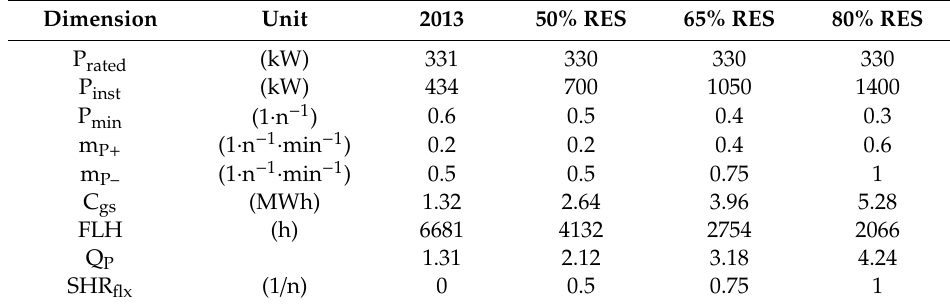
Table A4. Parameter set for biogas plant with on-site CHPU modified and expanded according to [14,25].